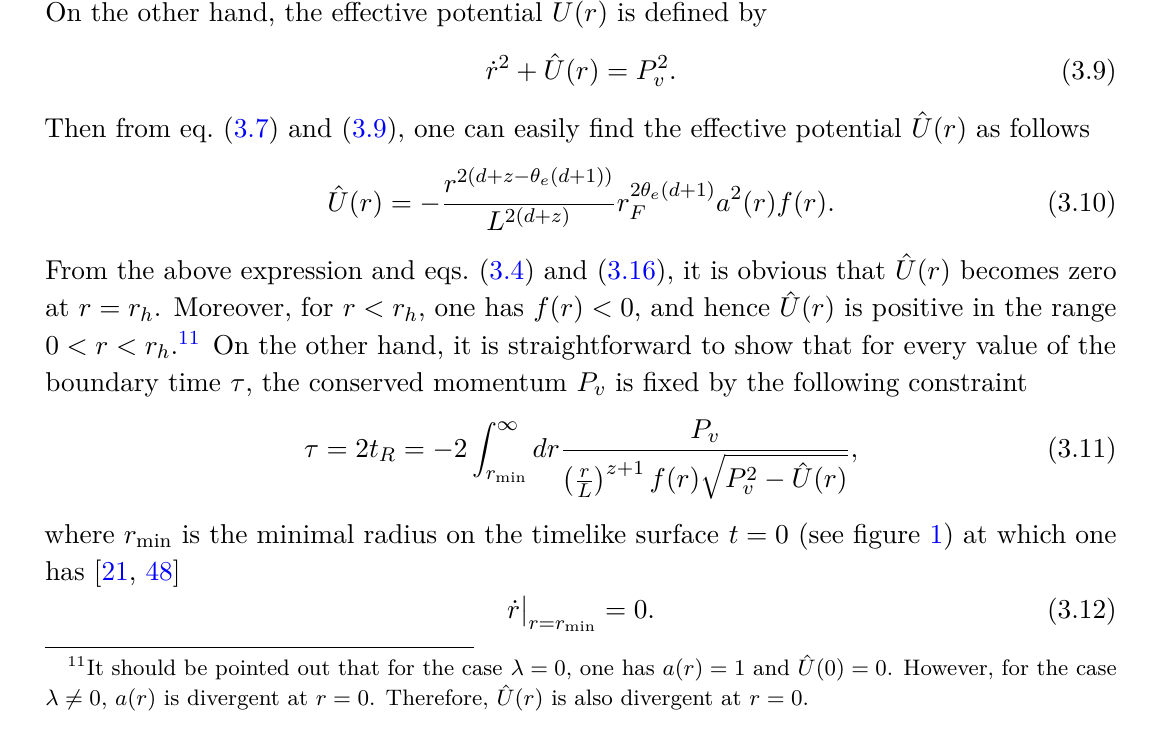
, then goes inside the horizon and reaches the minimal radius r L = t = τ . At late times, i.e. τ → ∞ , it approaches L R 2 which is denoted in blue. The red dashed f . Moreover, the magenta straight line denotes the extremal max = t = 0 which is applied in the calculation of the complexity of L R